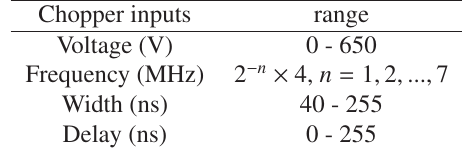
Table 1. List of Chopper inputs that can be selected and their